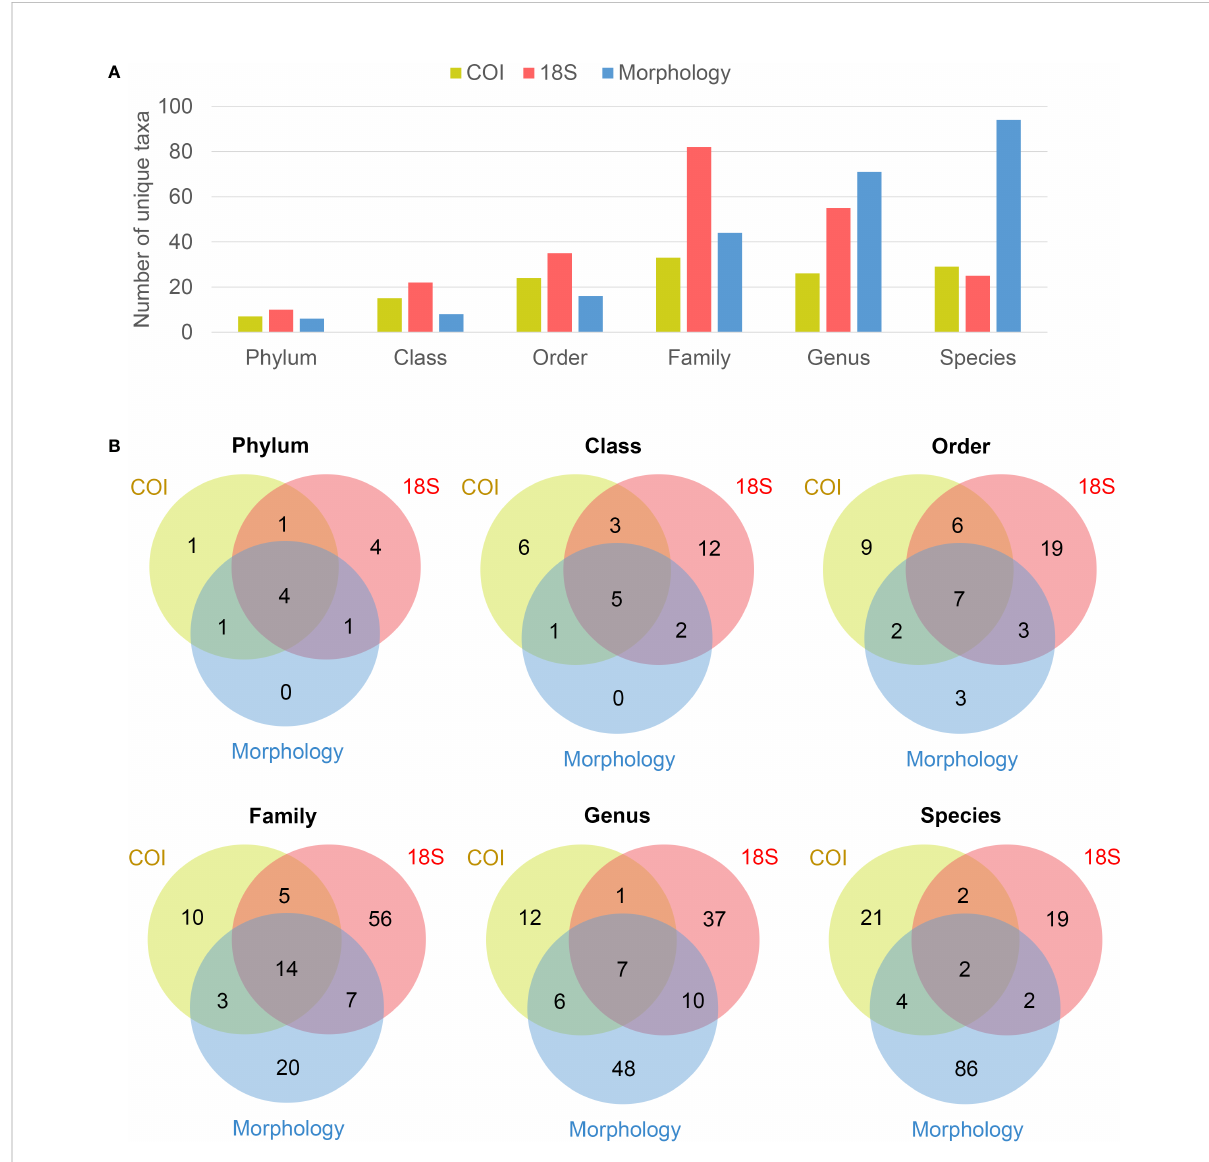
FIGURE 3 Numbers of mesozooplankton taxa detected per taxonomic level with eDNA metabarcoding (COI and 18S) and morphology. (A) Bar plot, (B) Venn